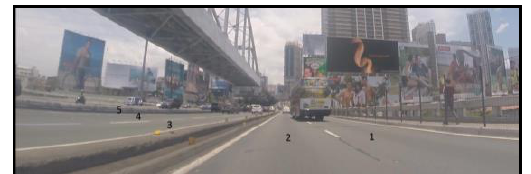
Figure 1. Lanes along the bridge; numbered from 1-5 where the